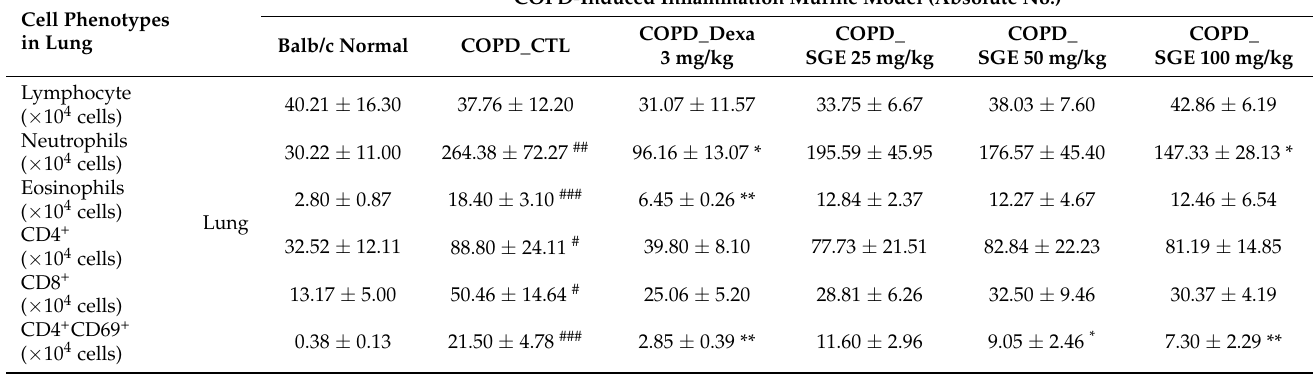
Table 2. The quantification of airway immune cell subtypes by FACS analysis in lung and MLN of SGE-treated COPD-induced inflammation